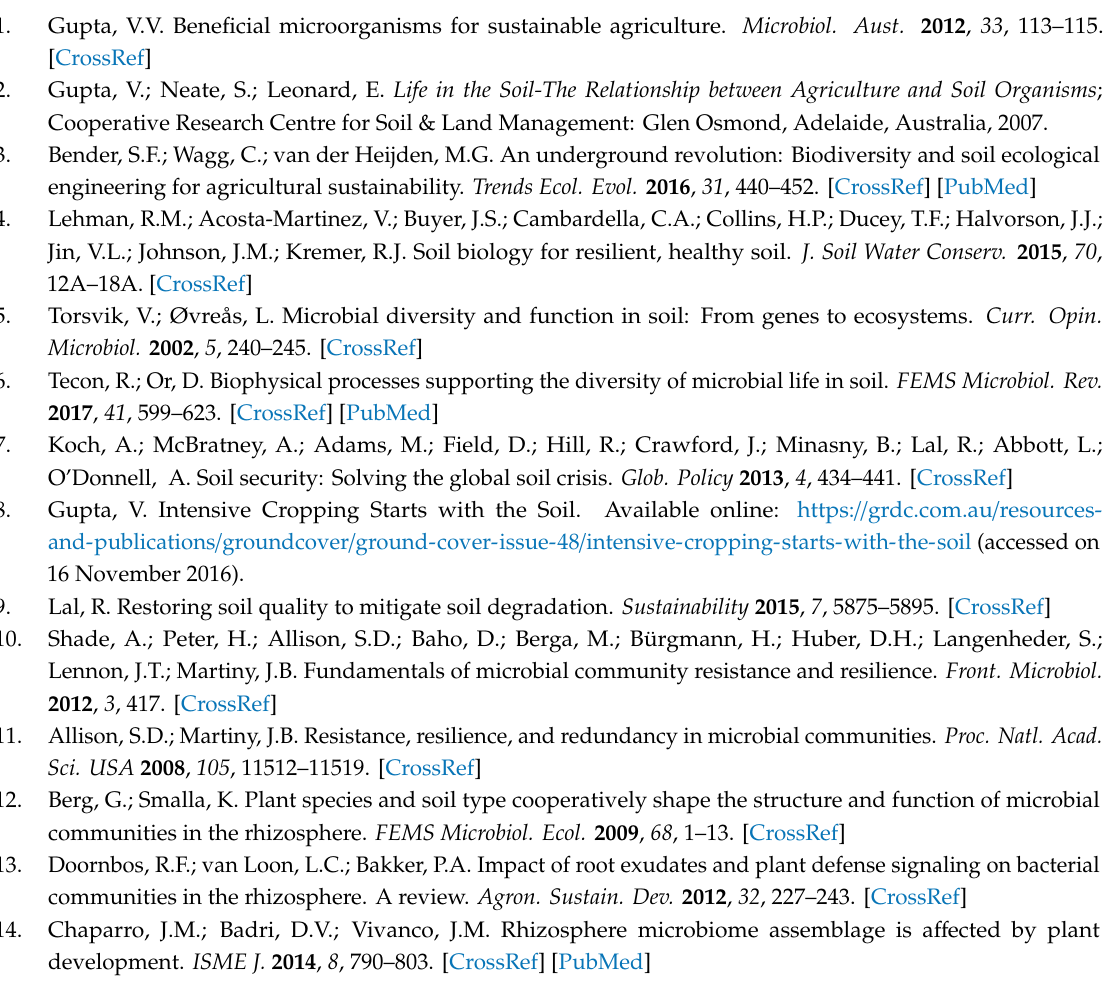
Figure S1: Distance-based redundancy analysis (dbRDA) plot of 16S absolute abundance OTU data against environmental factors (Table S1) where, based on a distance-based linear model (DISTLM) sequential tests [1,2], Figure S2: Distance-based redundancy analysis (dbRDA) plot of ITS absolute abundance OTU data against environmental factors (Table S1), based on a distance-based linear model (DISTLM) sequential tests [1,2], Table S1: Compilation of available soil characteristics and environmental parameters over the two growing seasons. Underlined superscript numbers correspond to footnote